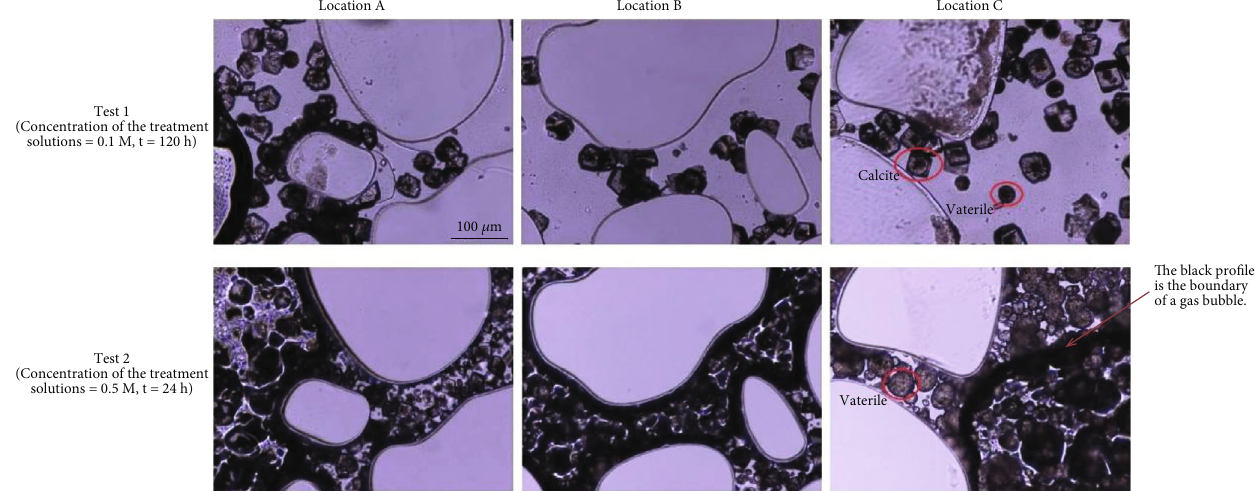
Figure 6: Polymorphs of CaCO Location A